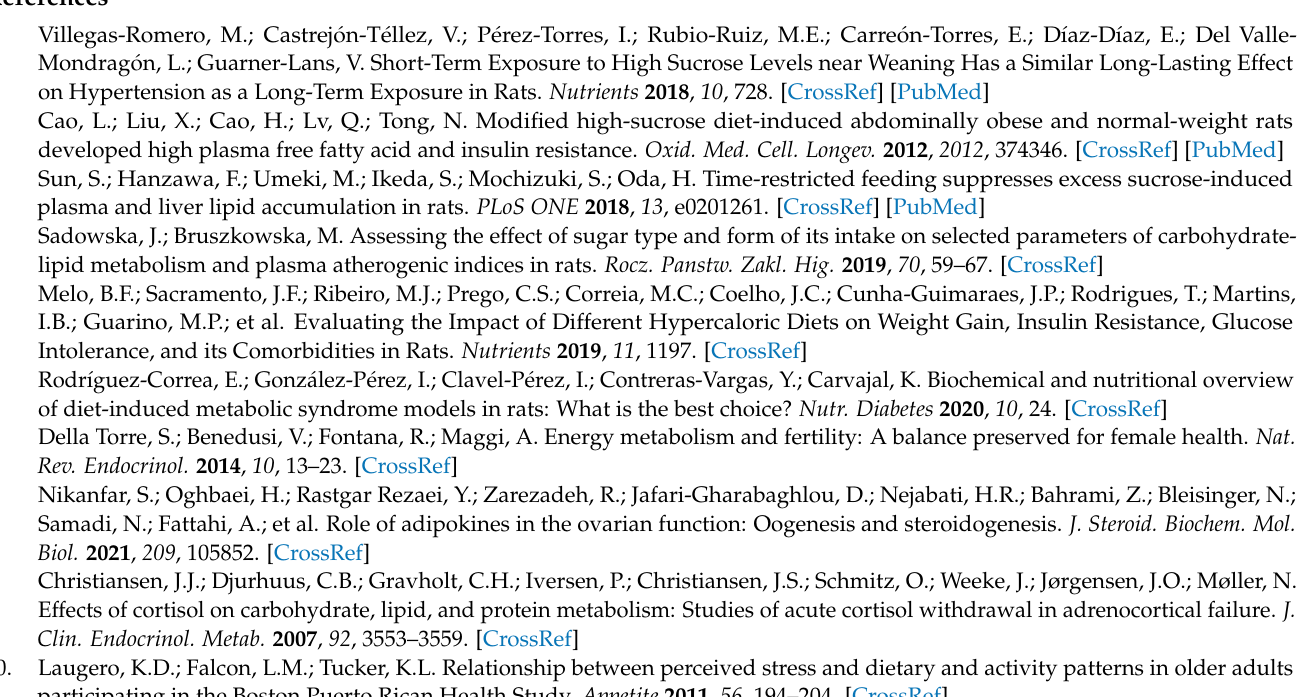
Table S2: Chemical composition of diets; Table S3: The course of the estrous cycle in females from the control group (CG); Table S4: The course of the estrous cycle in females from the sugar balanced group (SBG); Table S5: The course of the estrous cycle in females from the high sugar group (HSG); Table S6. The course of the estrous cycle in females from the alternately fed group (AFG); Table S7: The course of the estrous cycle in females from the periodically starved group (PSG). Table S8: p -values for the statistics of hormone concentration